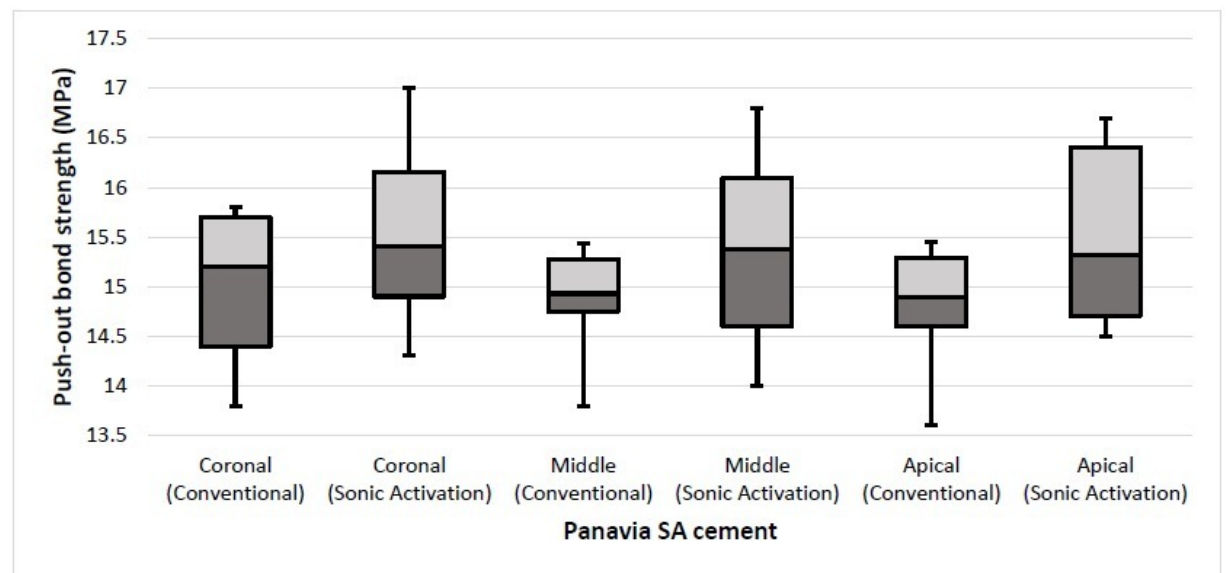
Figure 4. Comparison of mean bond strength between conventional and sonic activation at different root levels in Panavia SA SARC.